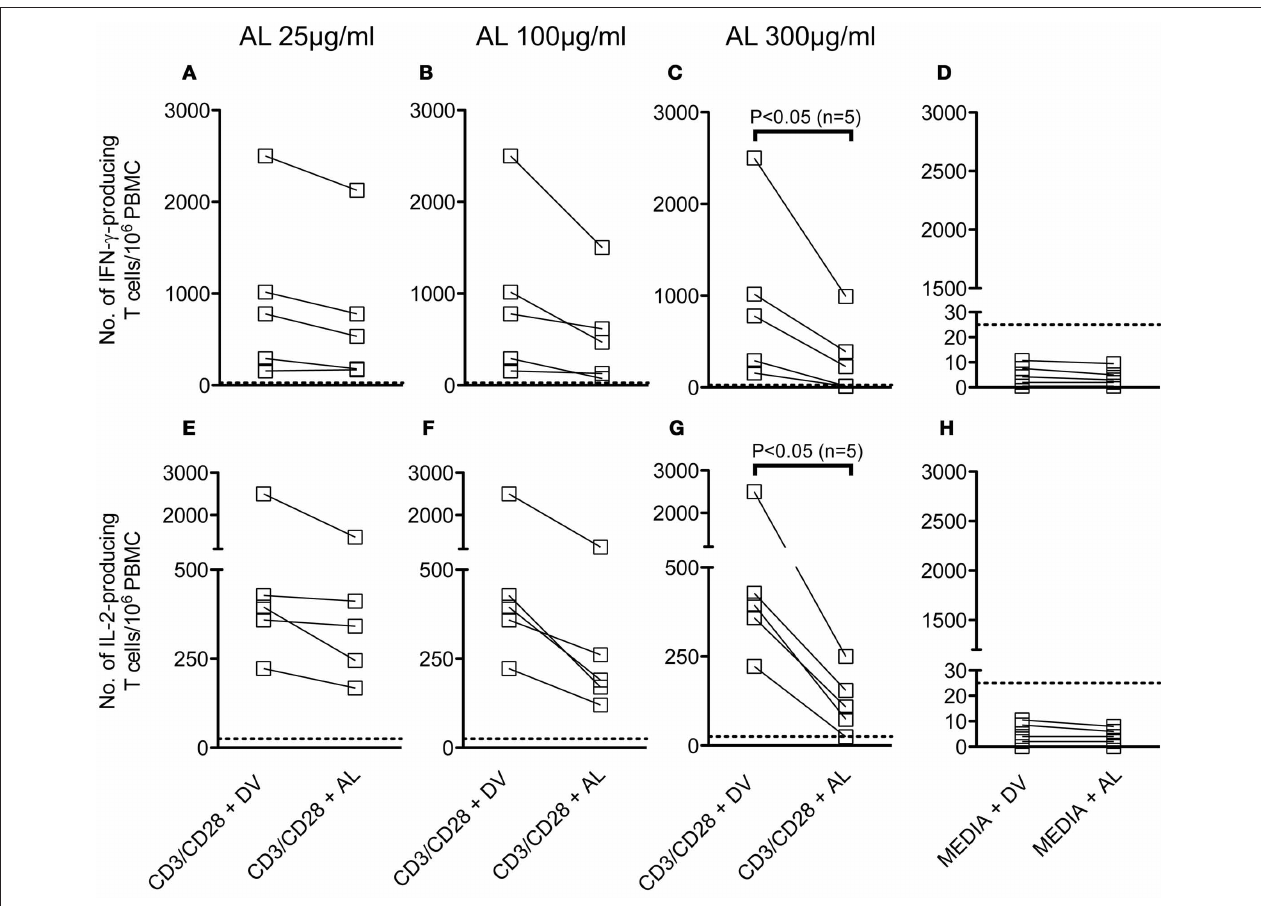
FIGURE 2 | Effect of different concentrations of allopurinol on polyclonal activation-driven IFN- γ and IL-2 production by human T cells. PBMC from healthy donors were stimulated with anti-CD3 (100ng/ml) plus anti-CD28 (100ng/ml) antibodies, or remained with media alone, in the presence of different concentrations of allopurinol ( + AL) or drug vehicle ( + DV), for 18–20h and the number of IFN- γ -secreting (A–D) or IL-2-secreting (E–G) T cells were determined by ex vivo ELISPOT assays. (D and H) The samples